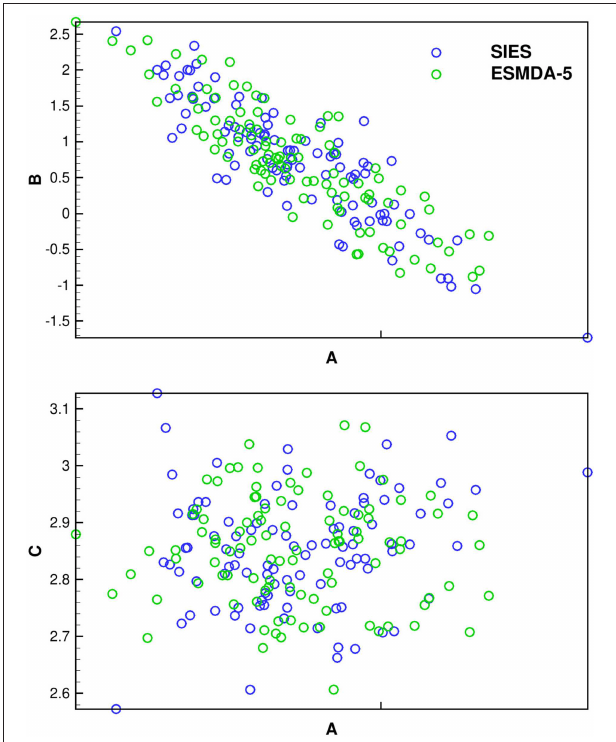
FIGURE 6 | The upper plot shows the values of the individual cost functions for each ensemble member as a function of iterations. The lower plot shows three average cost functions (averaged over the ensemble of cost functions) for the three versions of the inversion schemes. See section 5.3 for explanation of the different cases. The subspace schemes used a truncation at 99.9% of the